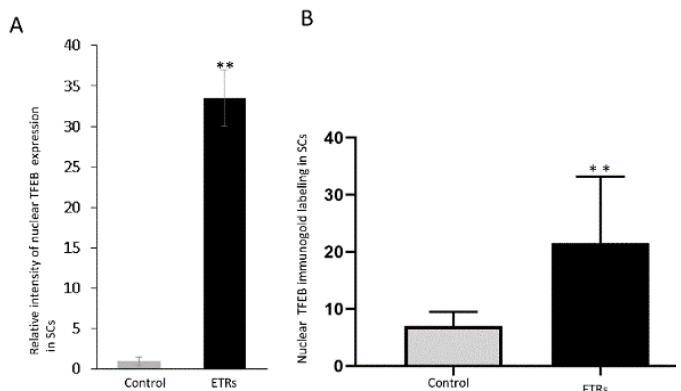
Figure 9. Quantitative analysis of nuclear TFEB expression and immunogold labeling in SCs. ( A ) Histogram showing significant increase of TFEB nuclear expression in ETRs SCs. ( B ) Quantification of nuclear TFEB immunogold particles in SCs. ** p < 0.01 ( t -test).